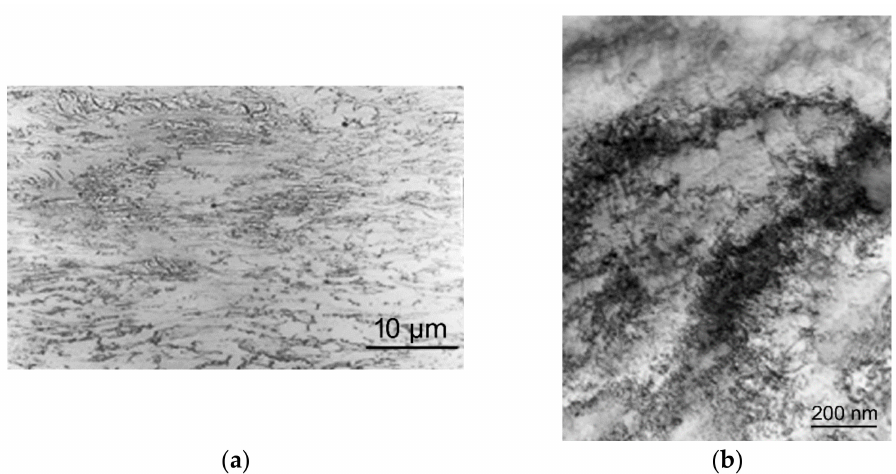
Figure 4. SEM image of the structure of impacted forehead of tested specimen, axial longitudinal section ( a ); TEM image of dislocations within deformed grains within structure of impacted forehead of tested specimen, axial longitudinal section ( b ).